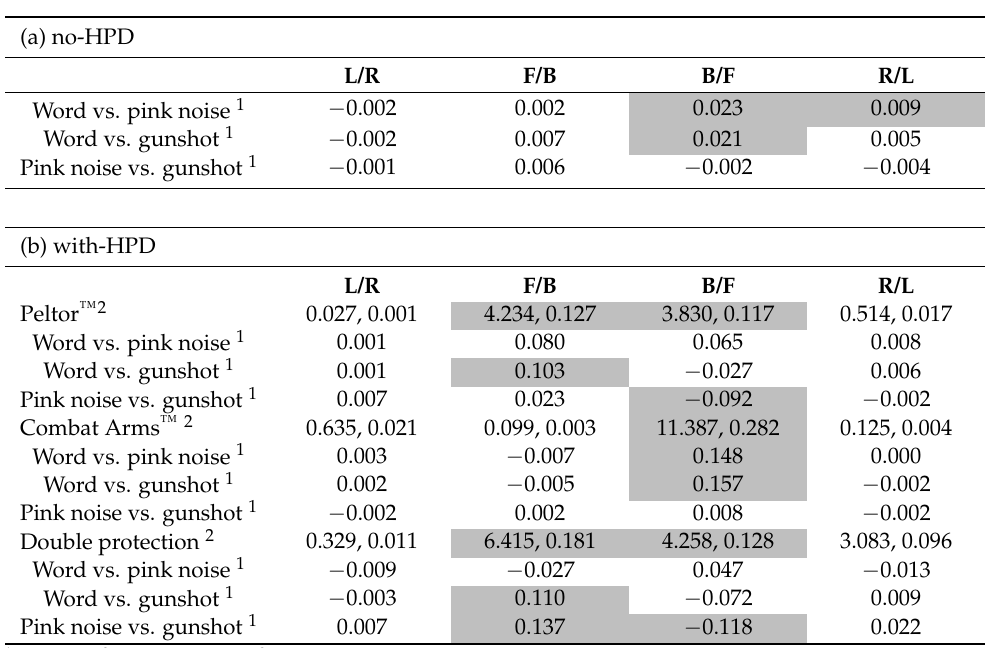
Table 6. Comparisons of mirror image reversal errors in each hemifield for the (a) no-HPD condition (LSD analyses between stimuli) and (b) HPD condition (main effects for each HPD, and post-hoc LSD analyses between stimuli for each